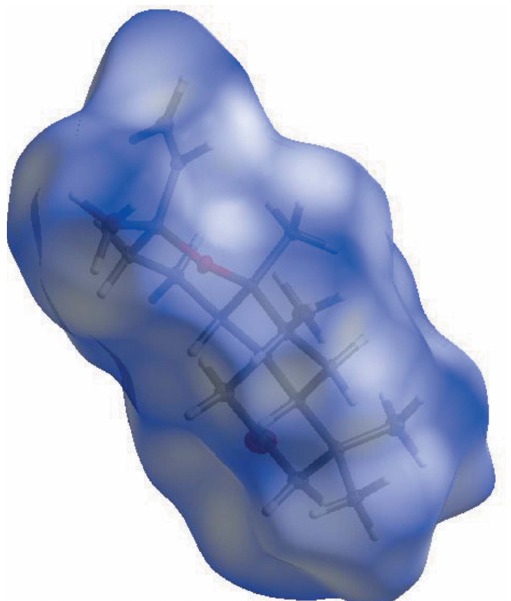
Figure 3 View of the three-dimensional Hirshfeld surface of the title compound mapped with d norm .